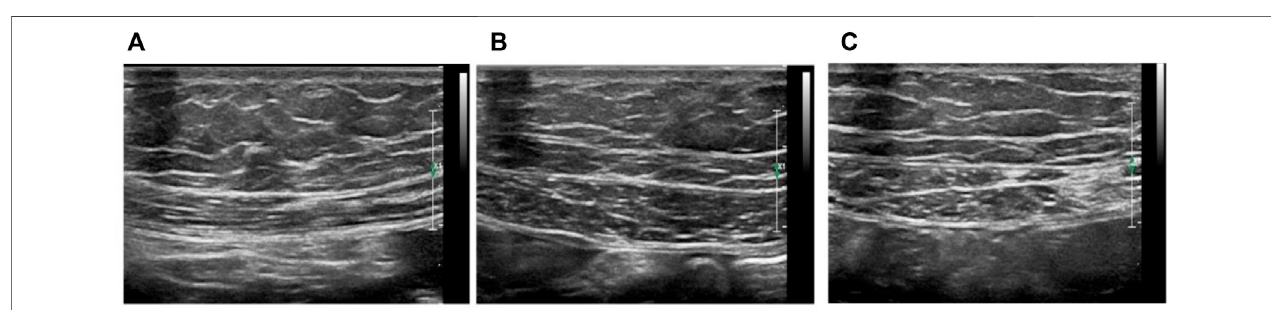
FIGURE 4 | Ultrasound analysis of rat respiratory muscles (A) Ultrasound measurement of diaphragm thickness, (B) Ultrasound images of left and right (C) rectus abdominis, bar = 2 mm.